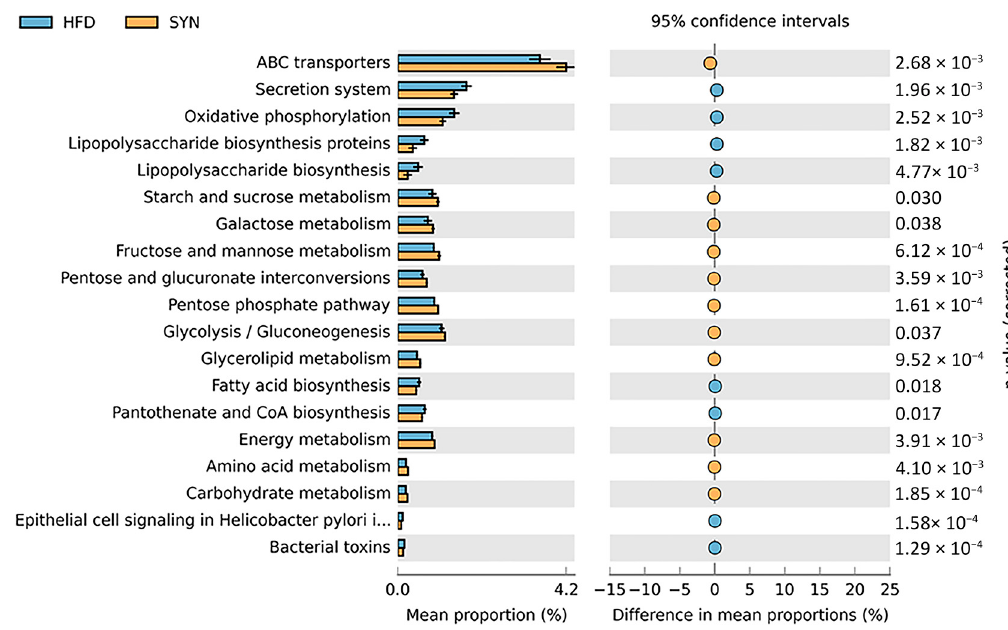
Figure 5. KEGG functional pathways predicted in the gut microbiome of HFD and SYN groups using PICRUSt. Significant differential KEGG pathways between HFD (blue) and SYN (yellow). Statistical analysis was carried out using STAMP software. Abbreviations: HFD, high-fat diet; SYN, high-fat diet + L. rhamnosus 4B15 + C. tricuspidata